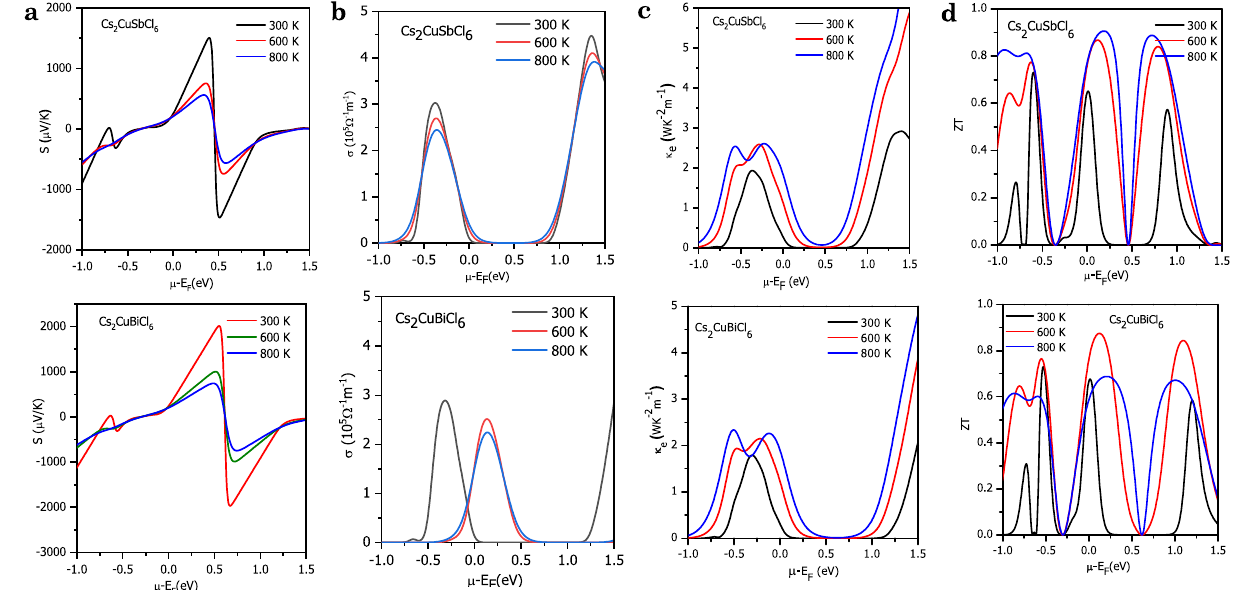
Figure 5. Variation in transport parameters with chemical potentials at different temperatures viz. ( a ) Seebeck coefficient; ( b ) Electrical conductivity; ( c ) thermal conductivity; ( d ) figure of merit (ZT). Different colors are used to distinguish the temperature: Black-300 K; Red-600 K; and Blue-900